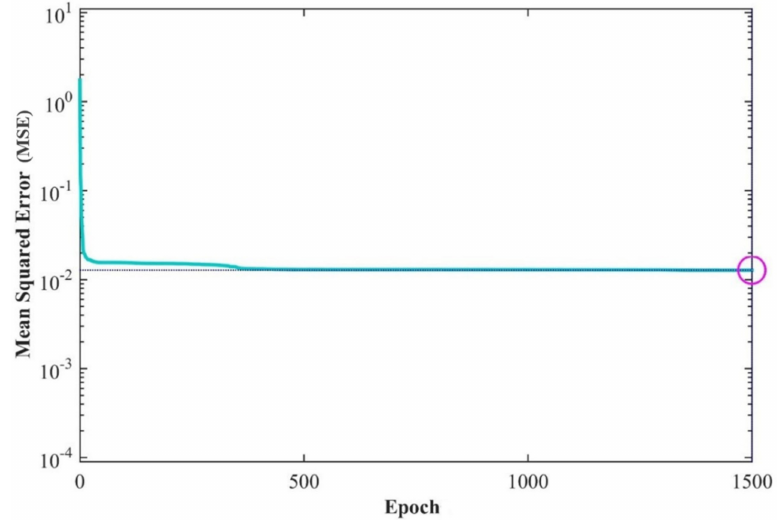
Figure 2. The performance of the Levenberg–Marquardt (LM) algorithm according to the mean squared